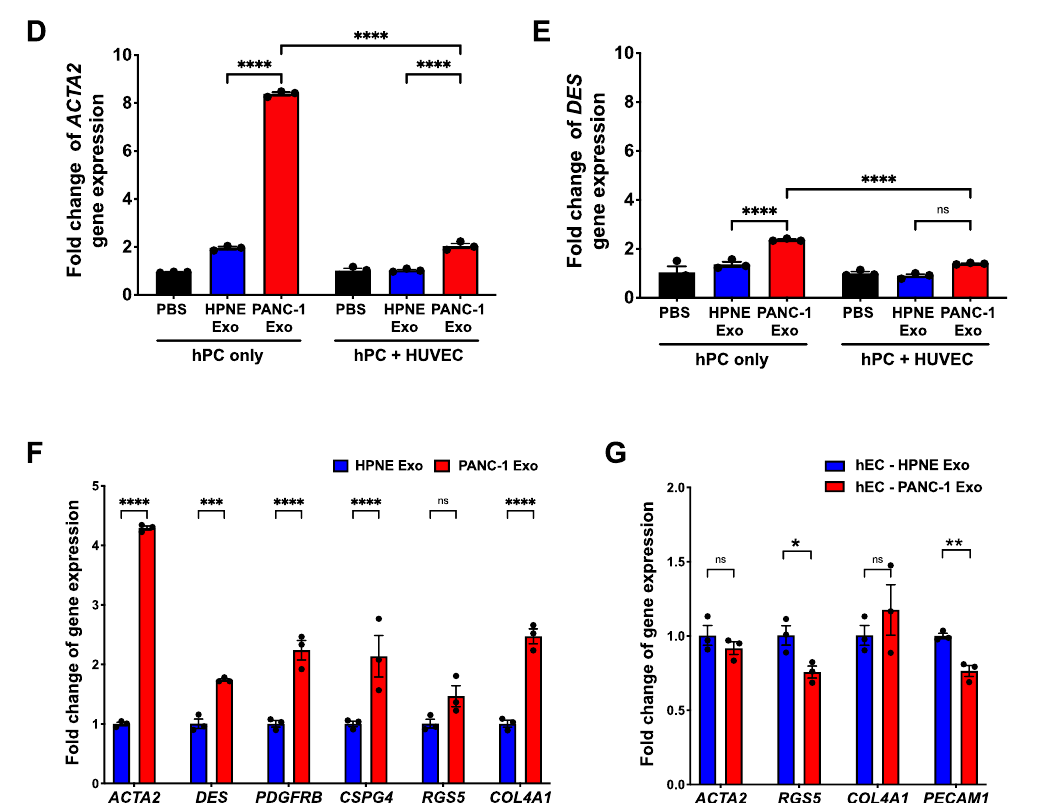
Figure 4. Pericytes ’ phenotype is influenced by pancreatic cancer cells. ( A – C ) Quantification of ACTA2 expression when pericytes are cultured in various conditions. ( A ) hPC was culture alone, with hEC (HUVEC), or KPC 689 cancer cells. ( B ) hPC was cultured in either a normoxic or hypoxic condition. ( C ) hPC and hEC were co-cultured at the bottom of a culture insert, and cancer cells (KPC or PANC-1) were cultured on the culture insert. ( D , E ) Either hPC alone or a hPC + hEC co-culture was treated with PBS, HPNE Exo or PANC-1 Exo. ACTA2 ( D ) and DES ( E ) expression levels were measured by qRT-PCR after exosome treatment. ( F ) Quantification of pericyte marker gene expression of hPC treated with HPNE Exo or PANC-1 Exo. ( G ) Quantification of endothelial cell gene expression of hEC treated with HPNE Exo or PANC-1 Exo. Endothelial gene expression was normalized by PECAM1. One-way ANOVA with Tukey’s multiple comparisons test was used for ( A , C – E ), unpaired two-tailed t -test was used for ( B ) and two-way ANOVA with Š í d á k’s multiple comparisons test was used for ( F , G ) to determine statistical significance. N = 3 for all experiments and the data are represented as the mean ± SEM. * p < 0.05, ** p < 0.01, *** p < 0.00, **** p < 0.000, ns = not